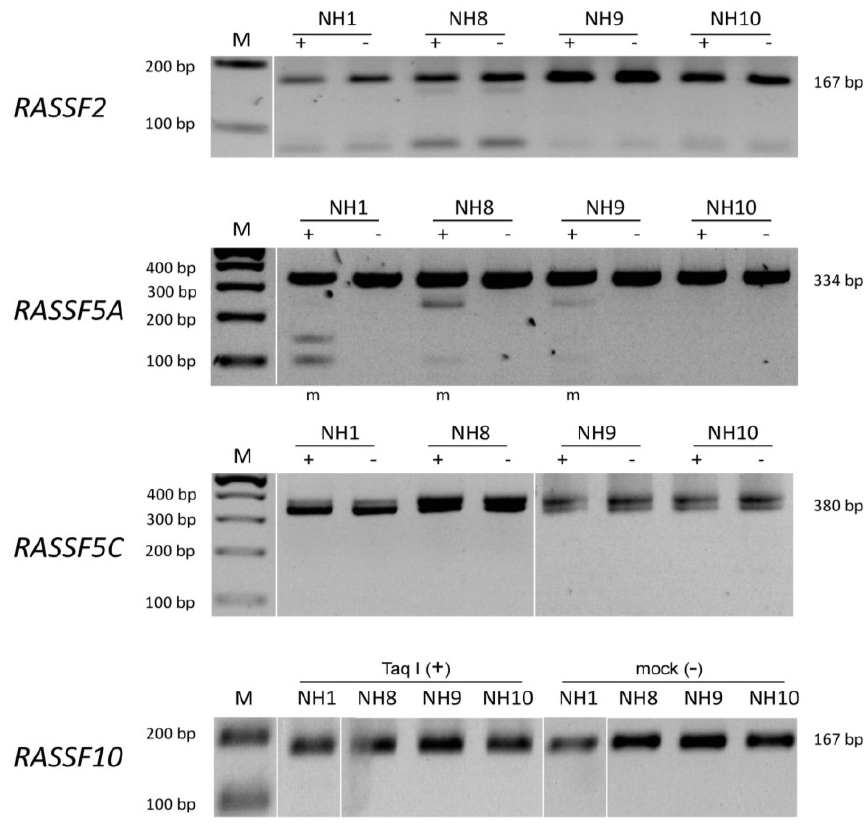
Figure 2. COBRA methylation analyses for RASSF2, RASSF5A, RASSF5C and RASSF10 in control tissue. Methylation analysis by COBRA for RASSF2, RASSF5A, RASSF5C and RASSF10 was performed and representative results are shown for different normal tissues (numbers are indicated above each gel). DNA was bisulfite treated and COBRA PCR with according primers was performed. Mock (−) and TaqI (+) digested PCR products are resolved in 2% TBE agarose gel together with 100 bp marker. Methylated samples (m) are indicated below and PCR product sizes are shown beside